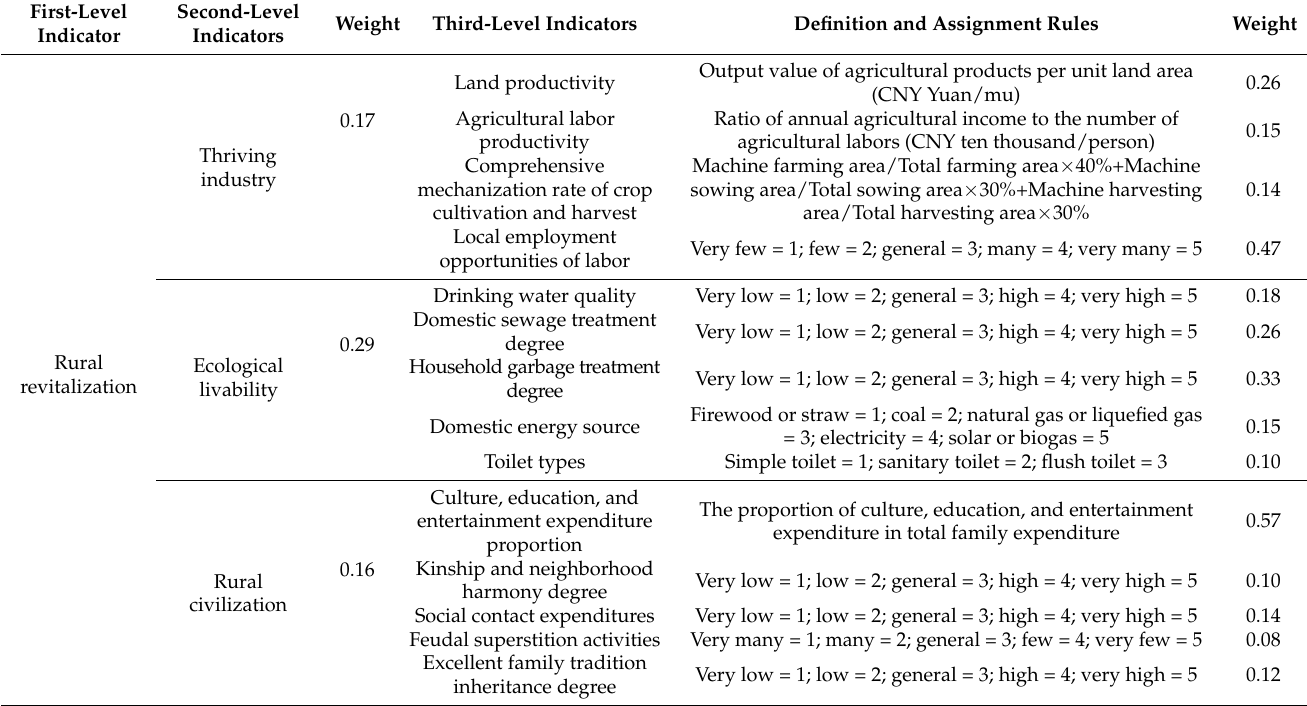
Table 1. The measurement indicators and its weight of rural vitalization and its five